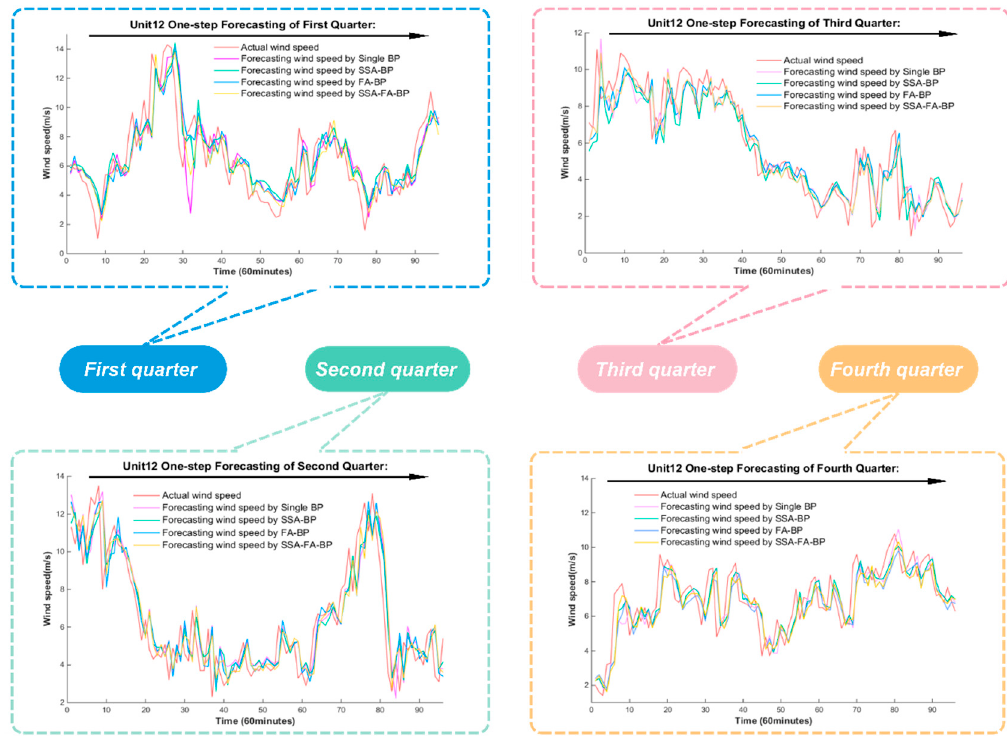
Figure 11. The quarterly forecasting results of the wind series of Unit 12 with one ‐ step (60 min).